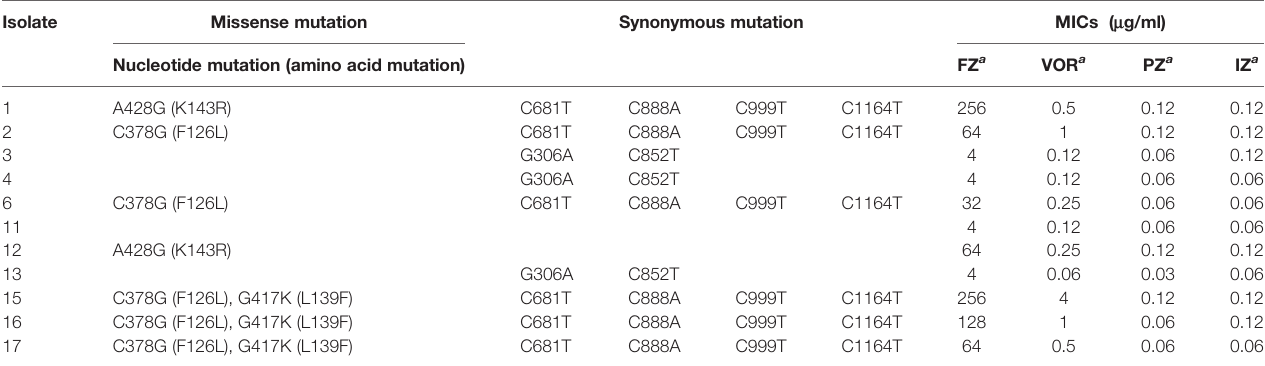
TABLE 4 | The variability of ERG11 gene in clinical D. catenulata isolates. Isolate Missense